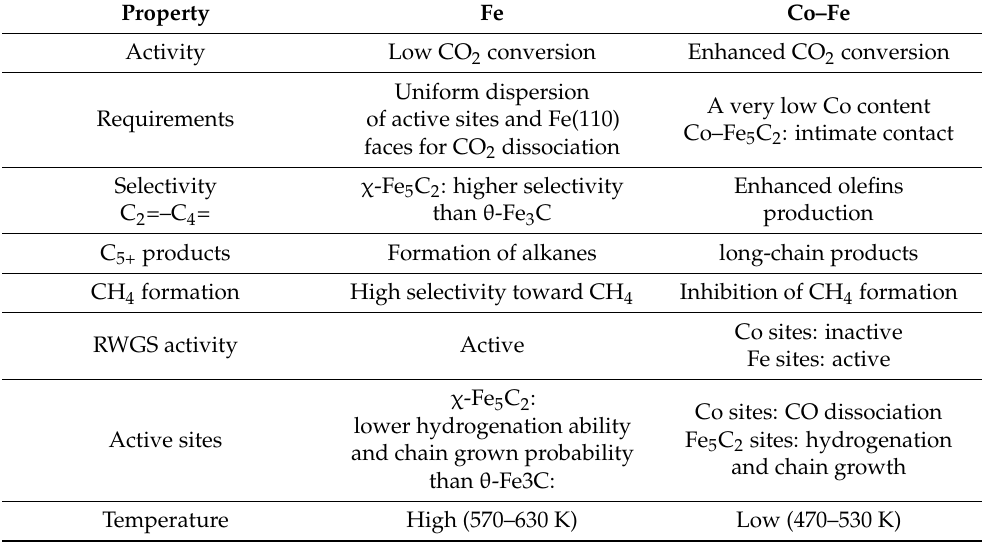
Table 1. Comparative overview of the features and olefins formation via RWGS + FTS route over Fe and Co–Fe